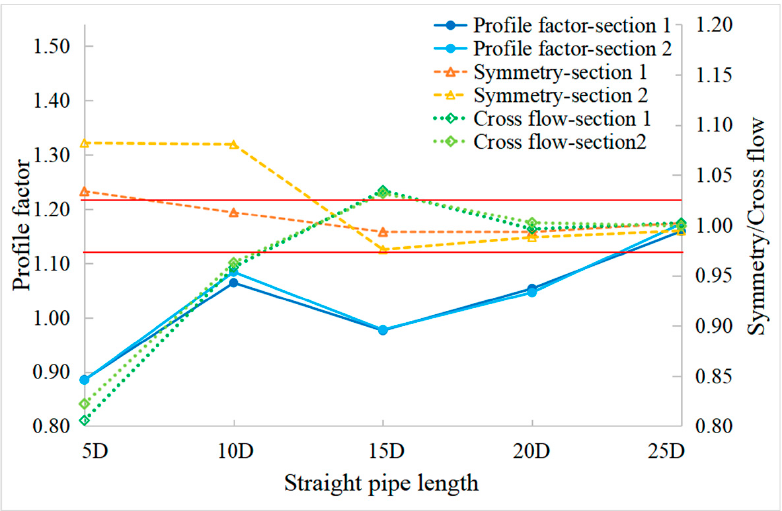
Figure 19. Characteristic parameters without FC.